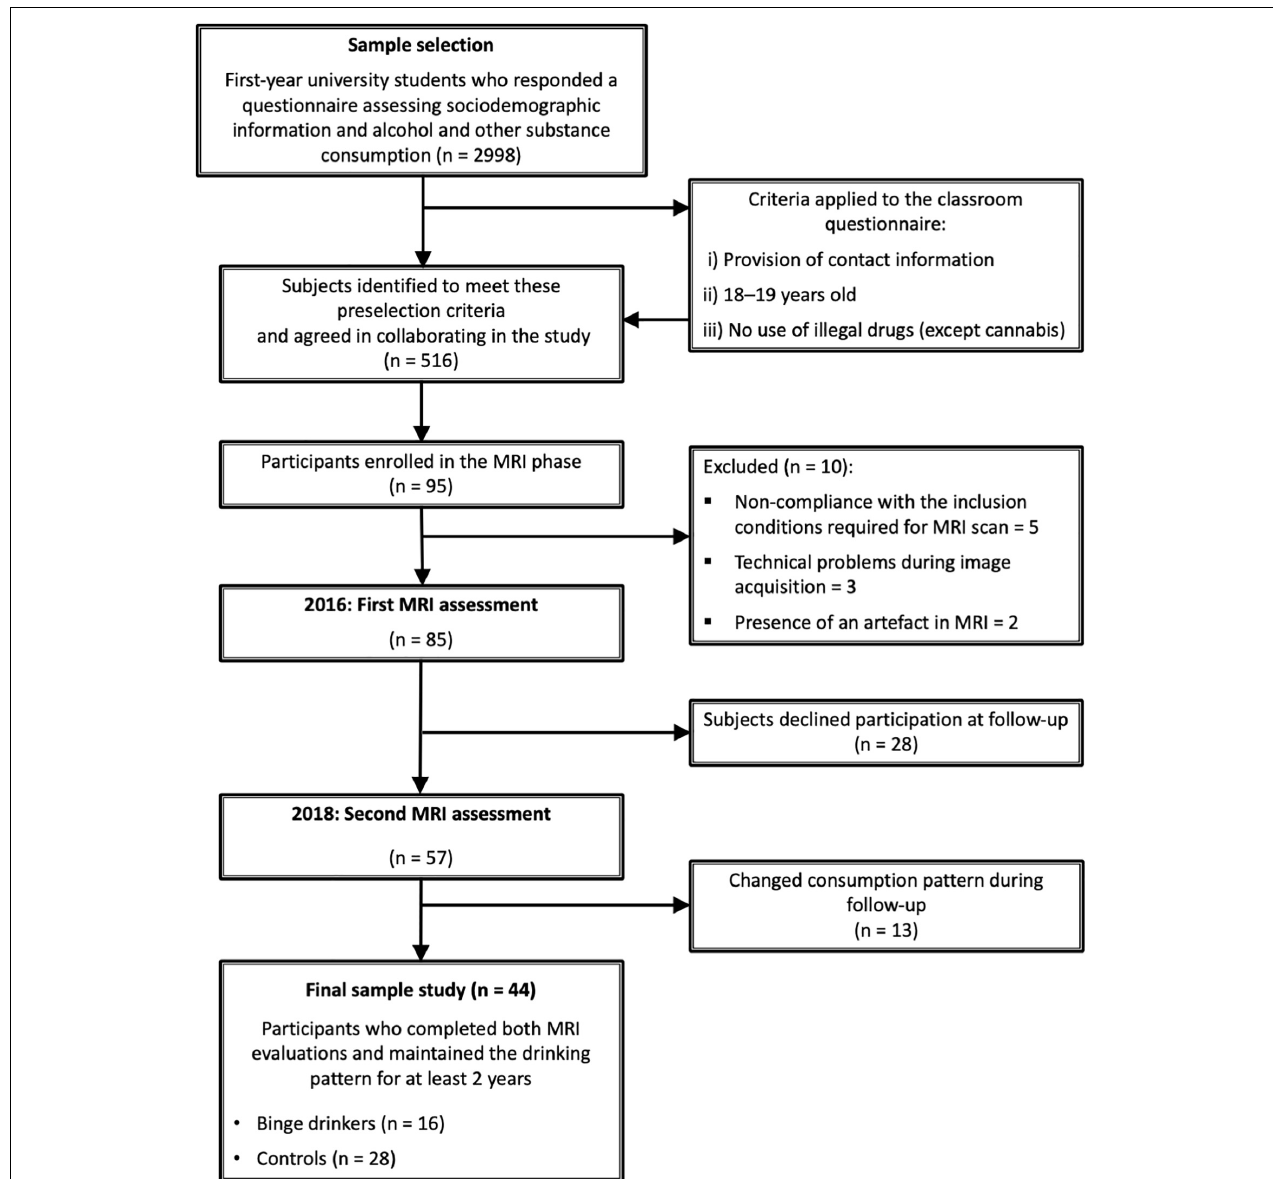
FIGURE 1 | Timeline with the phases of the